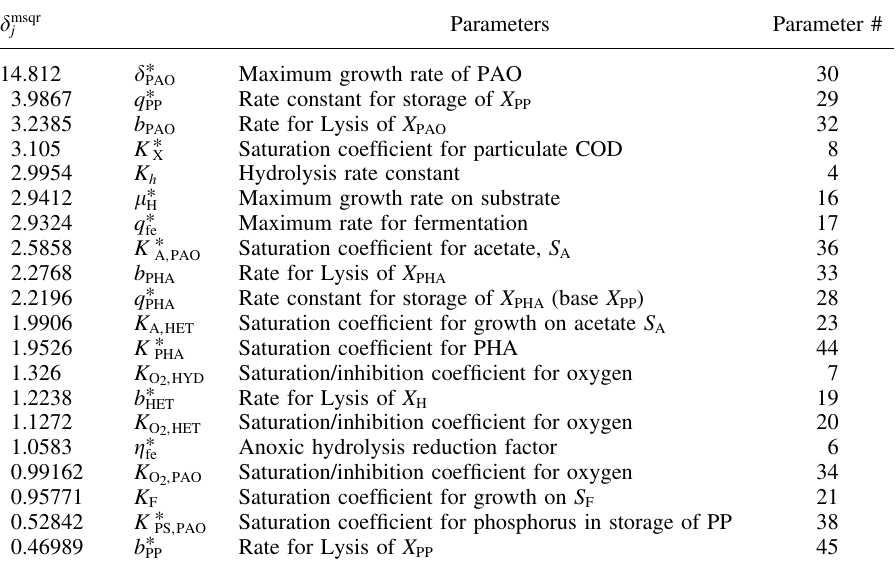
Table 4. Parameter importance ranking according to the sensitivity measures. Parameters labeled by an asterisk (*) are considered identifiable from the available data. (cid:12) msqr